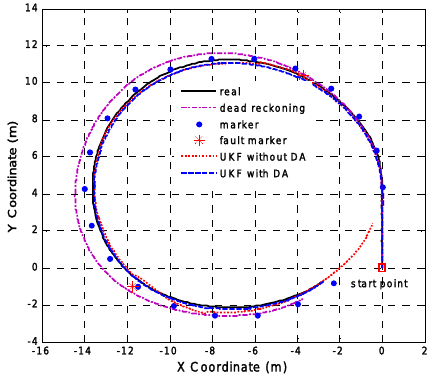
Fig. 6. Localization Results with Two Fault Markers